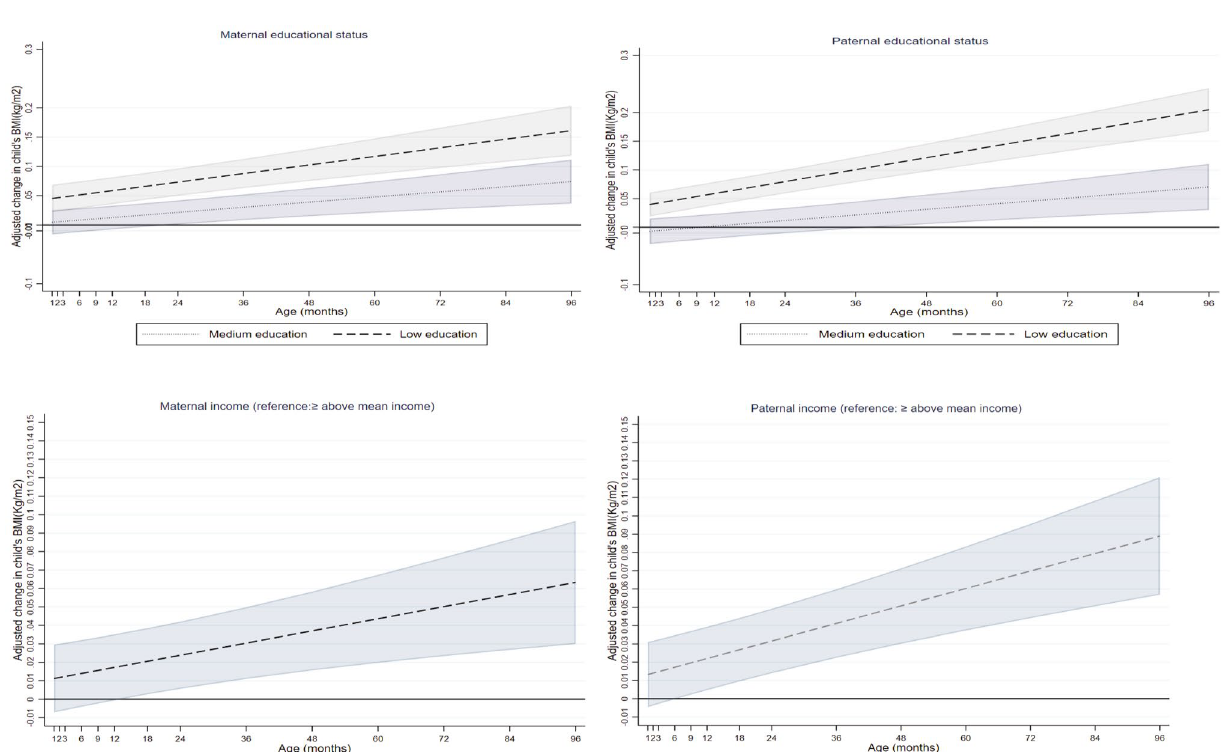
Figure 3. Associations between maternal and paternal education and income with children’s BMI from 1 month to 8 year (β coefficients in dash and dot lines and 95% CIs in solid